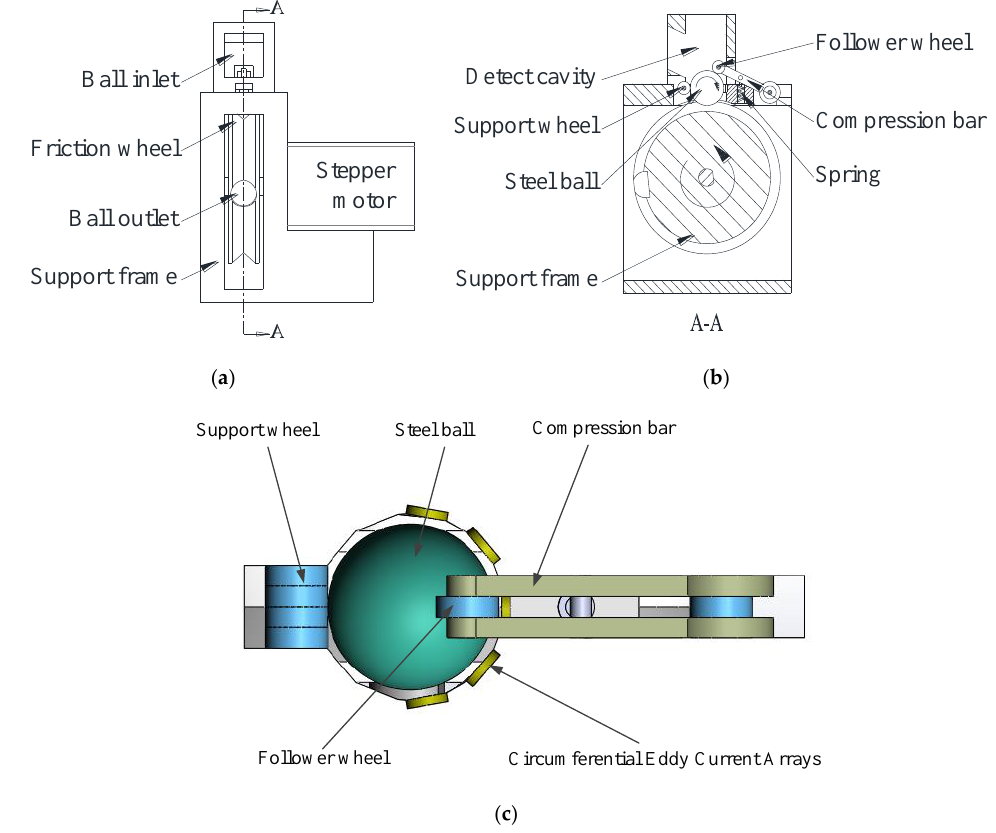
Figure 1. The unfolding mechanism of the steel ball. ( a ) The main view of the unfolding mechanism; ( b ) The cutaway view of the unfolding mechanism; ( c ) The top view of the unfolding mechanism.